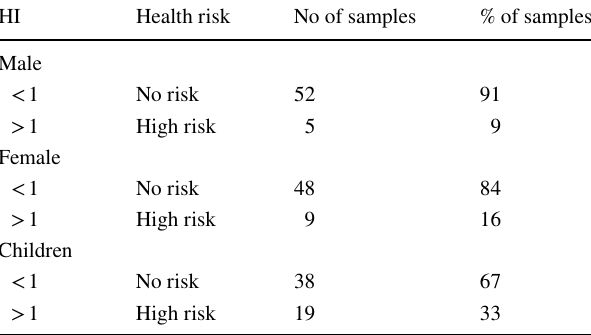
Table 6 Percentage of groundwater samples representing health risk